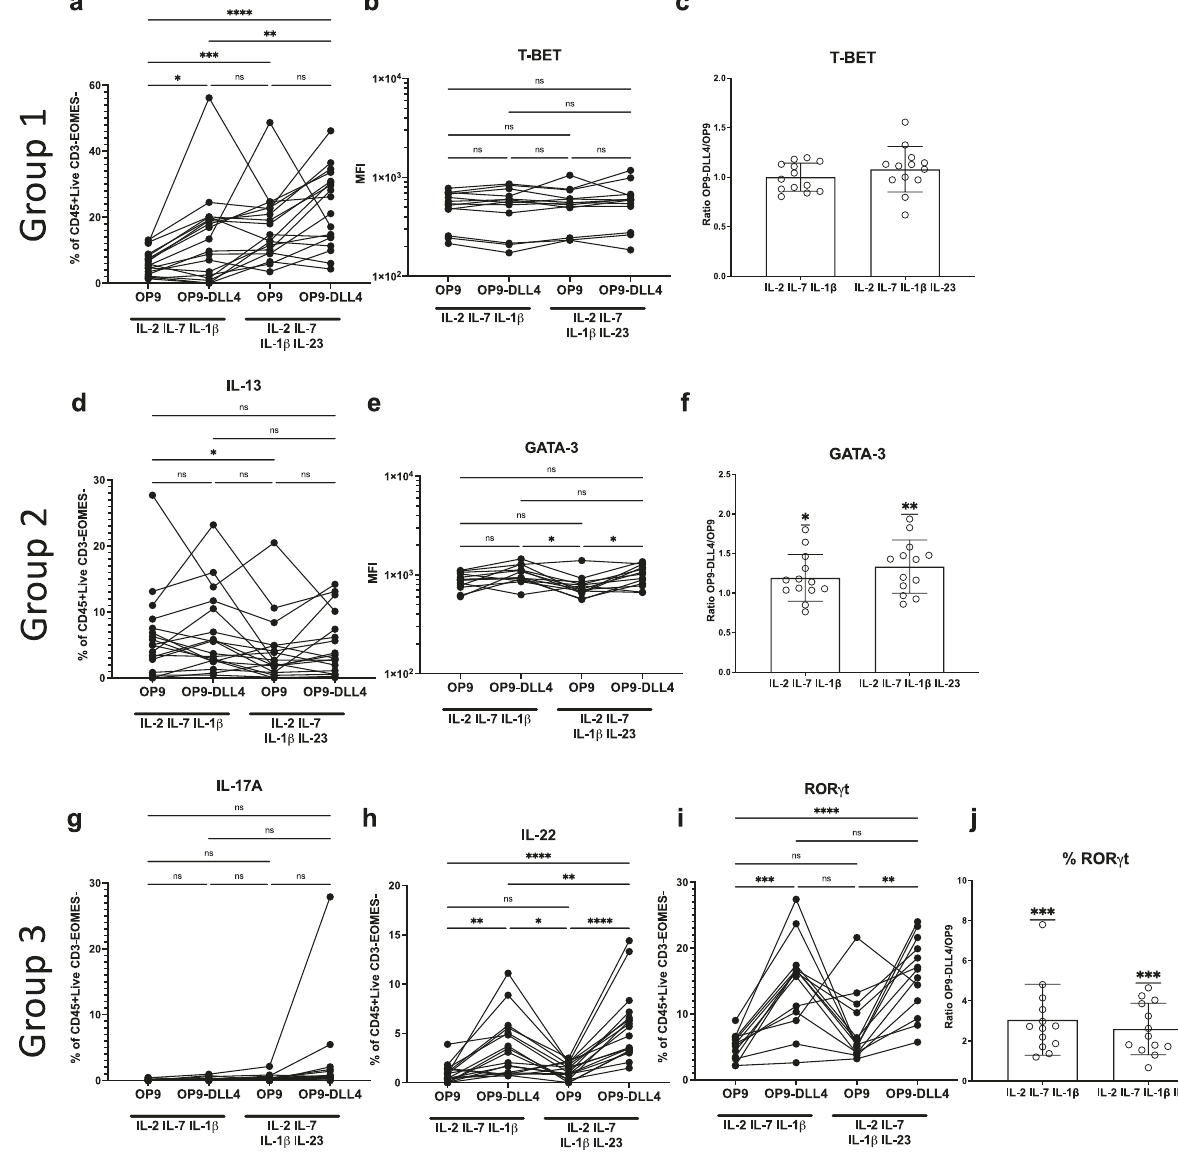
Fig. 1 | Effects of Notch and IL-23 signaling for human ILCP differentiation. ILC Group1,2and3cytokineexpression( n =18;afterP/Istimulation)andtranscription factors ( n =13) were assessed in bulk ILCP cultures (Supplementary Fig.